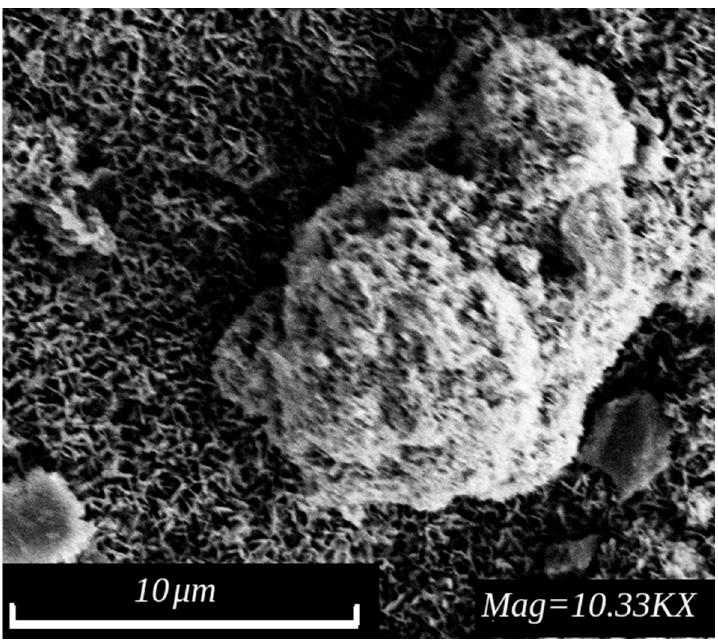
Figure 6. Electronic microphotograph of the steel St3 surface after 60 days of exposure. Linear structure—FeO(OH); bulk structure—CaCO 3 and its co-crystallized components.